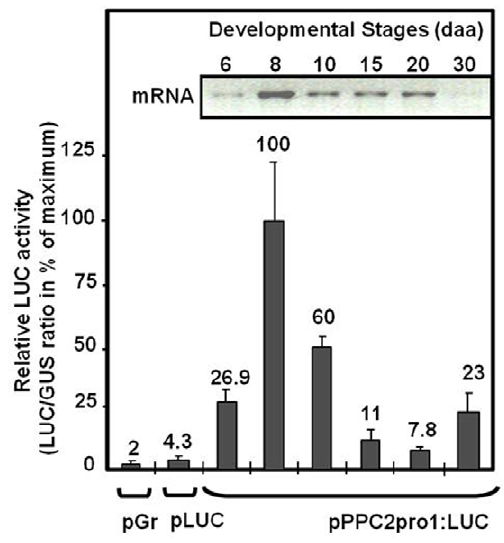
Figure 3. Transient reporter-gene expression analysis of the SlPPC2 promoter in developing tomato fruit («WVa 106» cherry). Fruit slices at the indicated stages of development from 6 to 30 days after anthesis (daa) were transformed by biolistic with a 35S:GUS plasmid co-delivered with a promoter:LUC fusion plasmid (promoter:LUC construct pPPC2pro1:LUC) that included the nucleotides –1528 to + 439 of SlPPC2 (with respect to the transcription start site). The pGr (plasmid alone) and pLUC (promoterless LUC construct) plasmids were used as negative controls to transform 8 daa fruit slices. Data were normalized using the 35S:GUS construct as internal standard and are expressed as % of maximum activity (8 daa fruit). The mean values and SE of 6 to 12 independent transformations are shown. Insert represents the RT-PCR analysis of SlPPC2 expression during wild-type tomato fruit